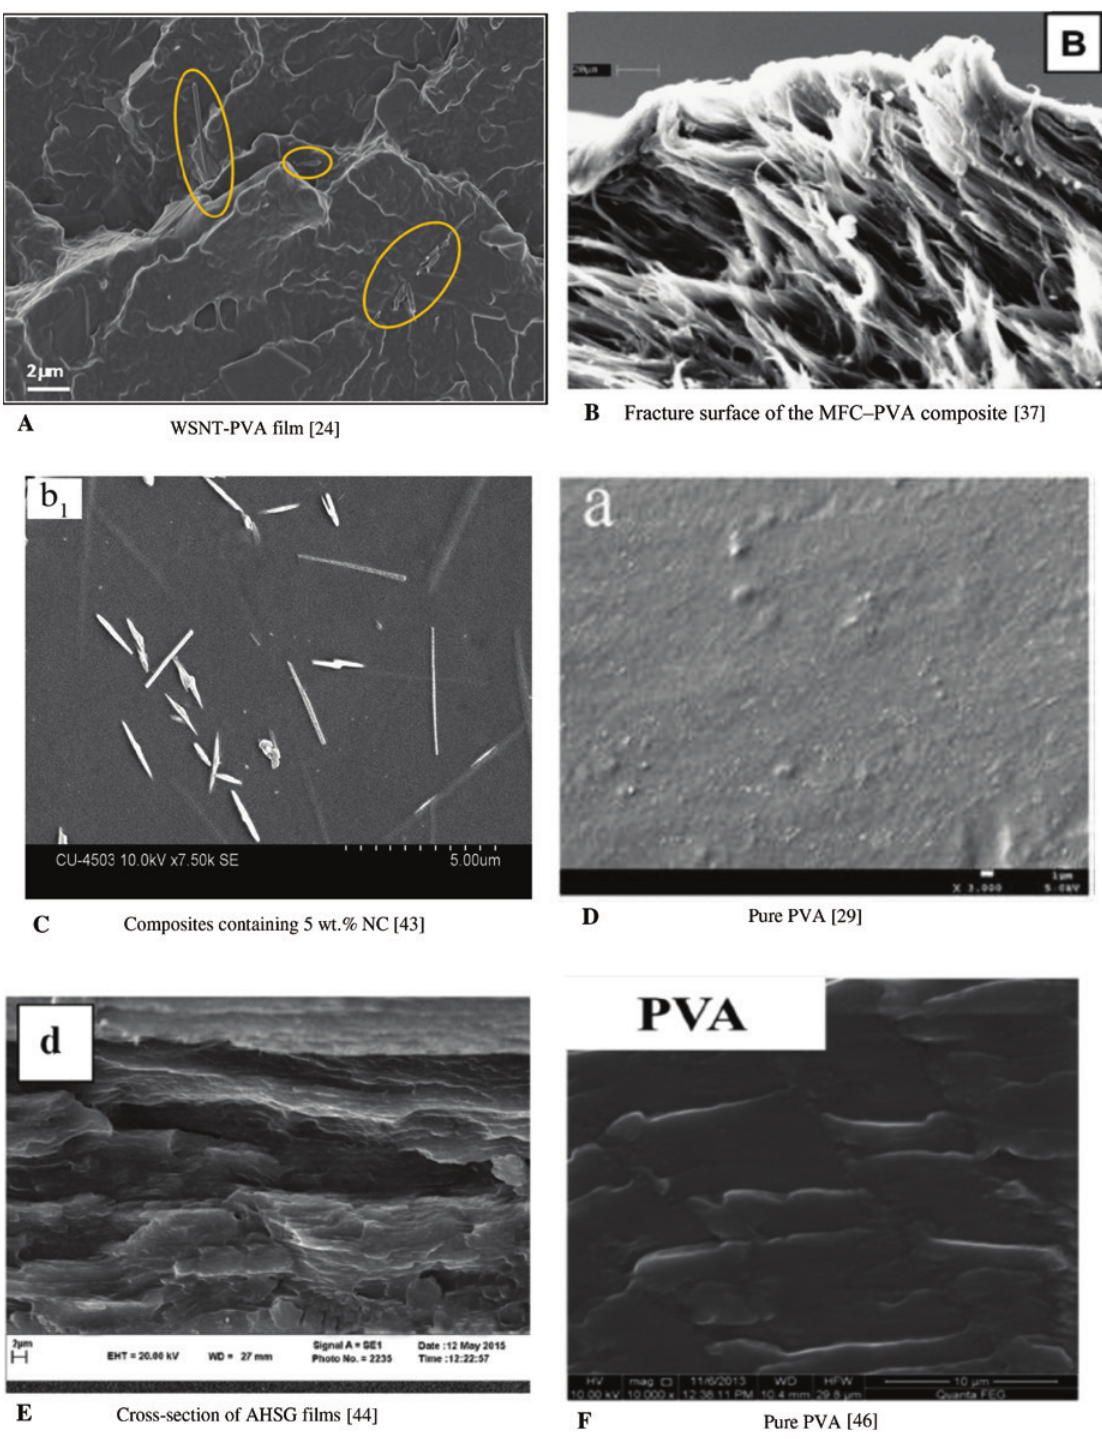
Figure 3: SEM image of PVA based composite/film. (A) WSNT-PVA film [24]. (B) Fracture surface of the MFC–PVA composite [37]. (C) Compos- ites containing 5 wt.% NC [43]. (D) Pure PVA [29]. (E) Cross-section of AHSG films [44]. (F) Pure PVA